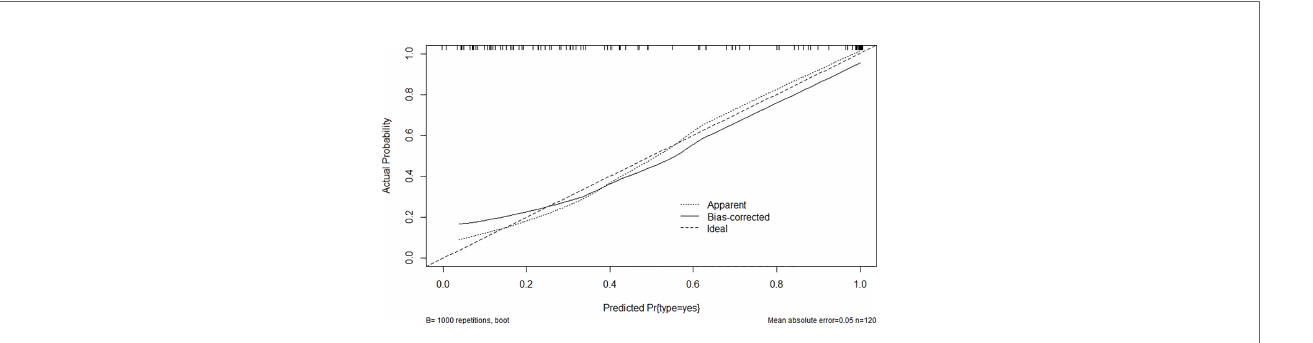
FIGURE 3 | Validity of the predictive performance of the nomogram in estimating the risk of DFU: (A) in the training cohort (n = 853) and (B) in the validation cohort (n = 120). DFU, diabetic foot ulcer.